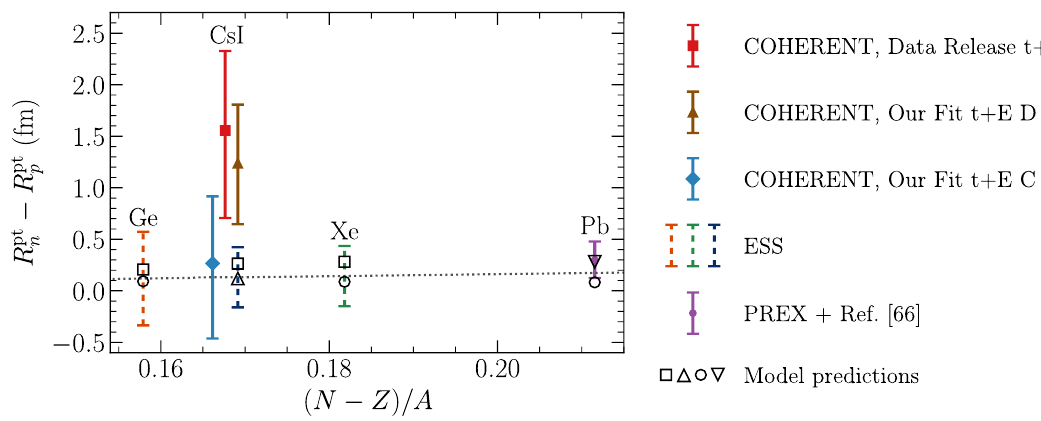
Figure 4 . Compilation of our results for the present determination and future sensitivity of the neutron skin thickness from CE (cid:23) NS experiments for the isospin asymmetric nucleus considered in this work. For clarity, the red and blue points corresponding to two analyses of COHERENT have been slightly displaced horizontally. For comparison we show the result for 208 Pb derived from the PREX measurement with the analysis in ref. [71], and the best-(cid:12)t to the indirect determina- tion from antiprotonic atom x-ray data for a variety of nuclei (dashed line), taken from ref. [48]. The hollow markers represent the range of predictions in a variety of models, see text for details. For concreteness, the expected results from the ESS have been centered on the dashed line, and correspond to our analysis with an energy-dependent ES uncertainty ranging from 1% to